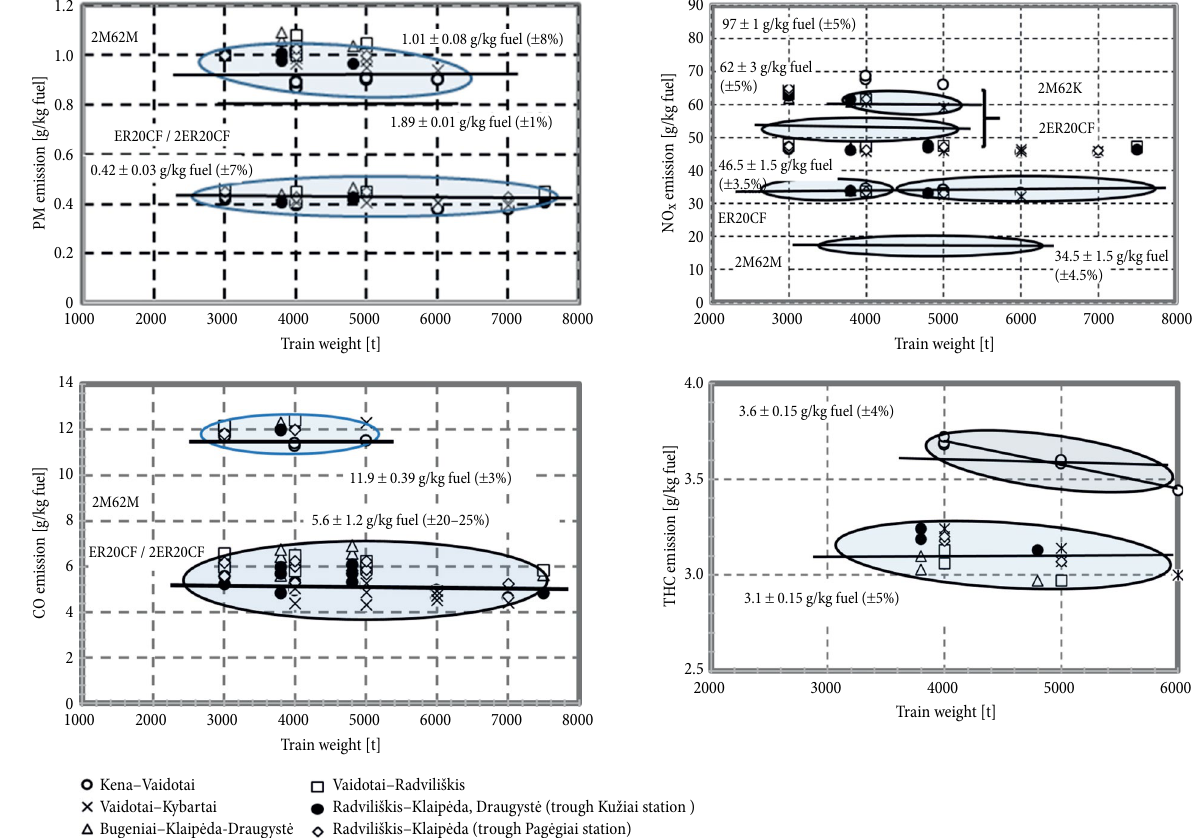
Fig. 3. Ecology indicators of diesel engines of freight locomotives (HCSE [g/kWh]) operated by the JSC ‘Lithuanian